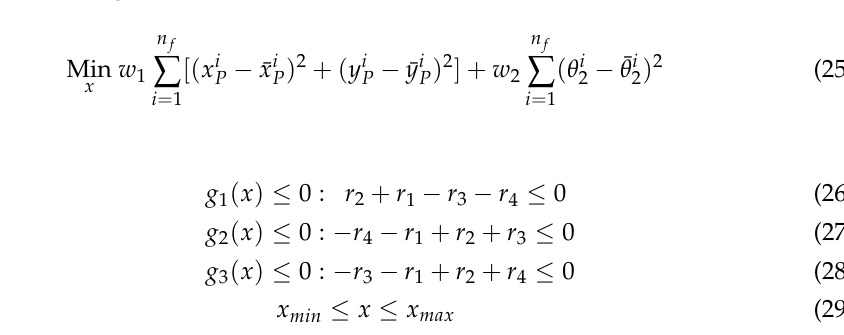
Figure 2. Four-bar linkage